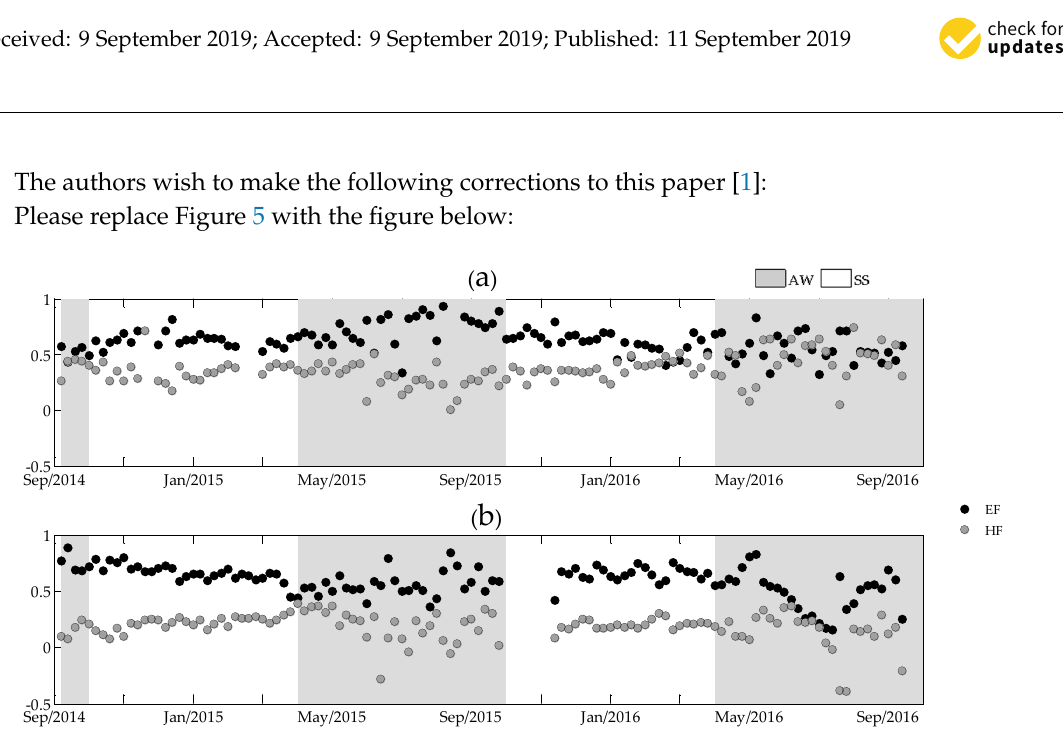
Figure 5. A 6-day average of the evaporative fraction (EF = LE / R n ) and heat fraction (HF = H / R n ) for ( a ) SMA and ( b ) PAS throughout Sept 2014 to Sept 2016. The hatched areas refer to Autumn–Winter (AW) periods.